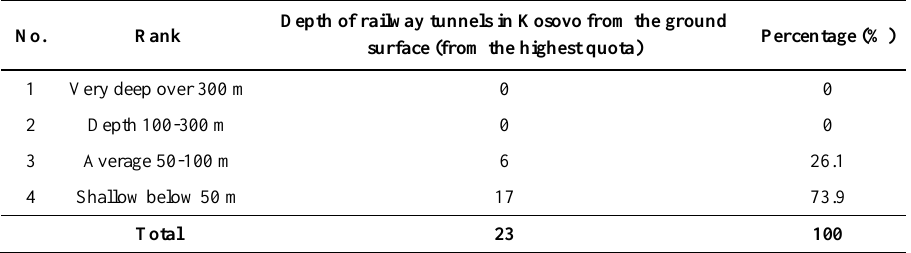
Table 7. Division of tunnels by depth